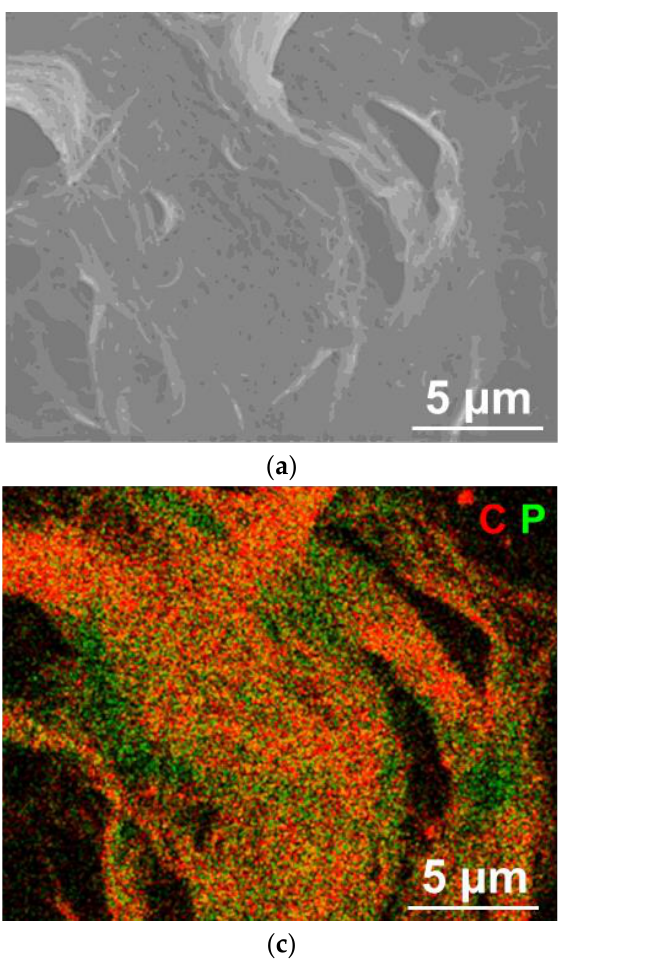
Figure 2. ( a , b ) SEM images and ( c , d ) corresponding EDS combined maps of carbon and phosphorus elements for ( a , c ) P@SWCNTs/P and ( b , d ) P@SWCNTs.